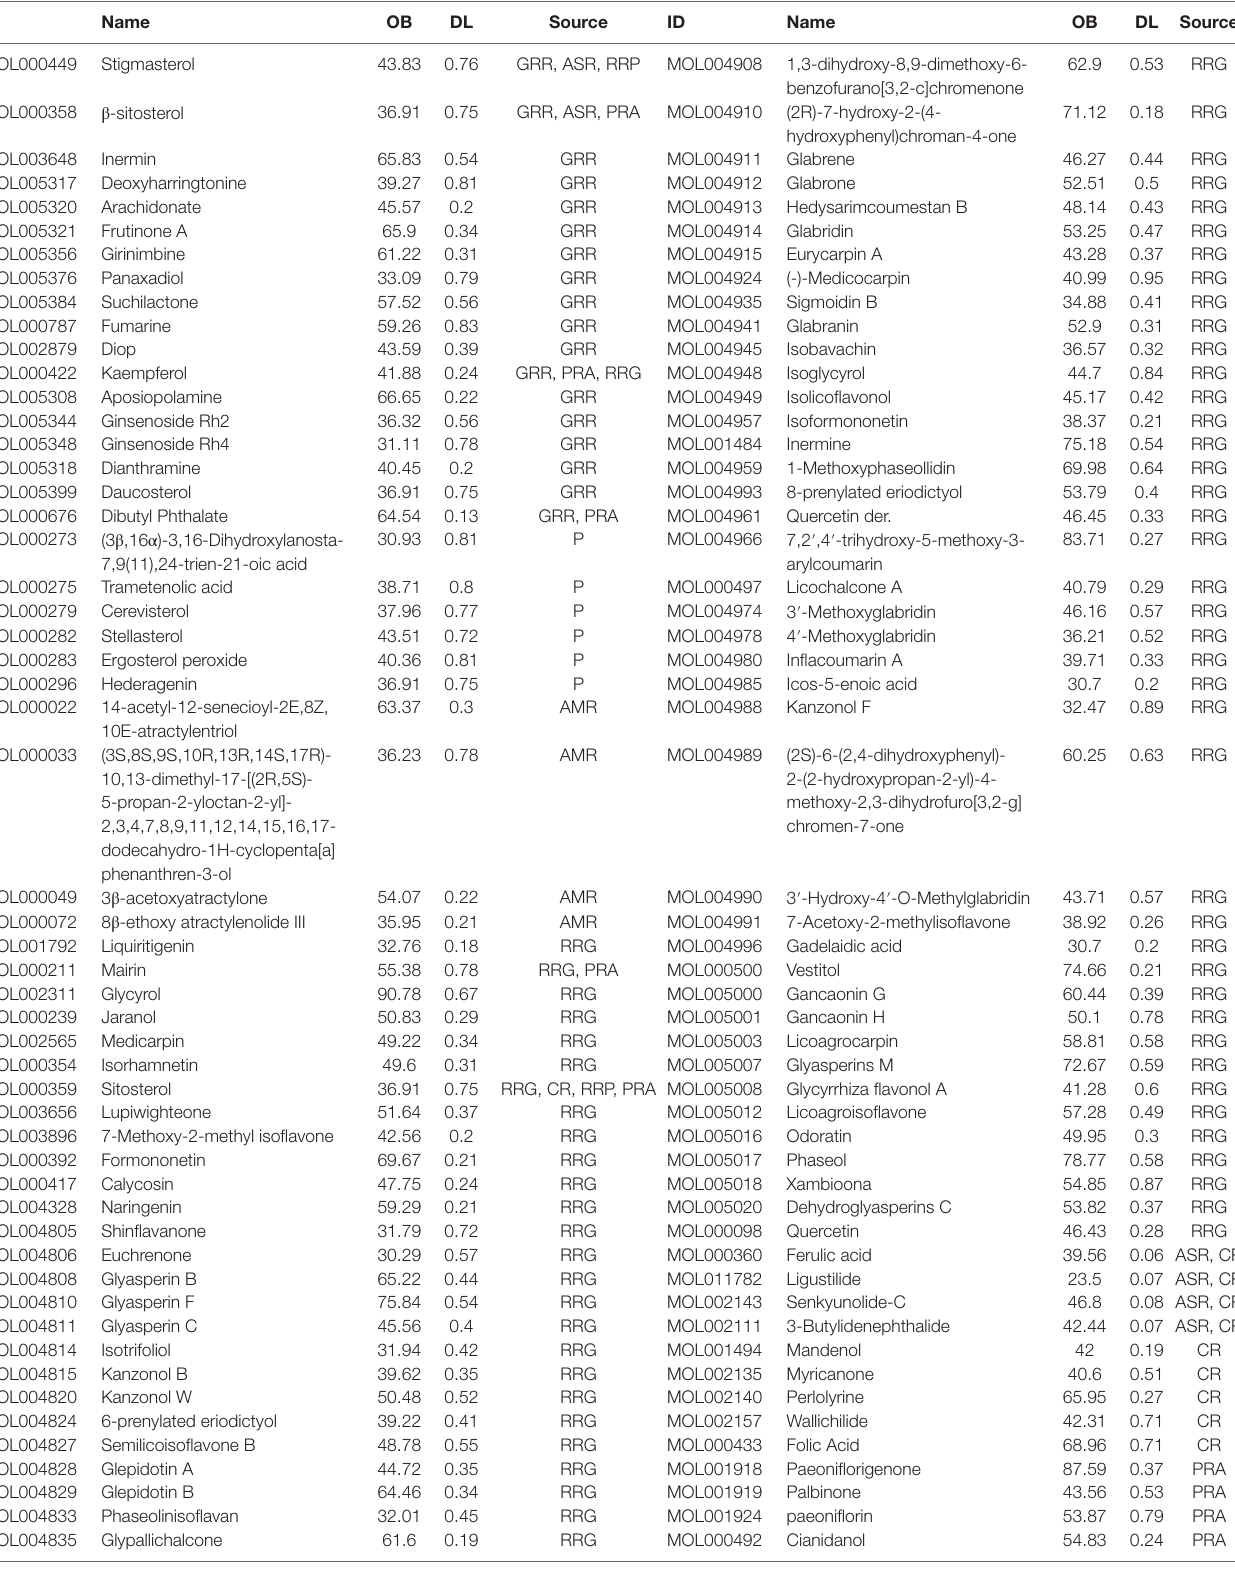
TaBlE 1 | The final selected compounds in YQSX for